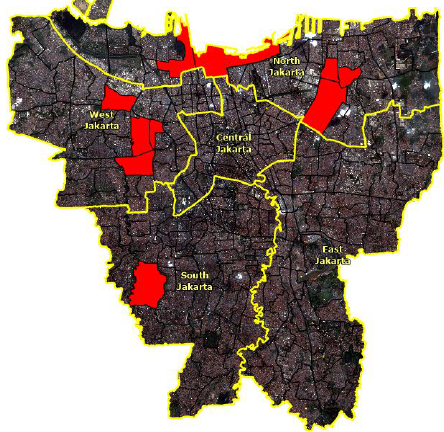
Table 1 . Details of village selected in study area